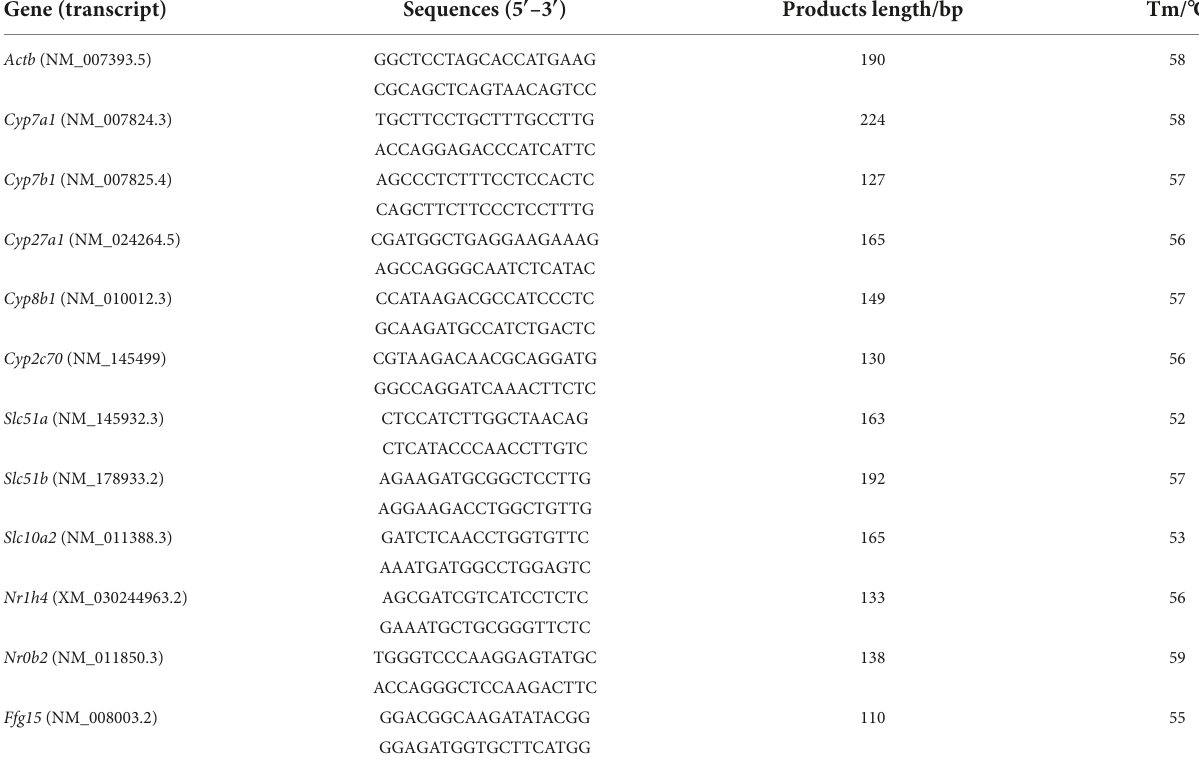
TABLE 1 Primer sequences used for